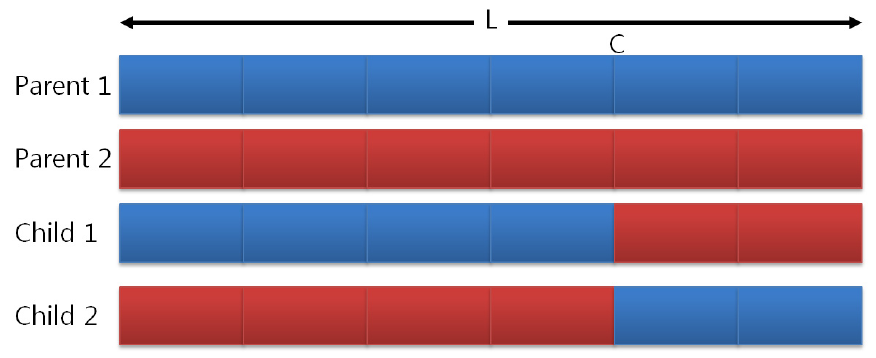
Figure 2. One-point crossover method